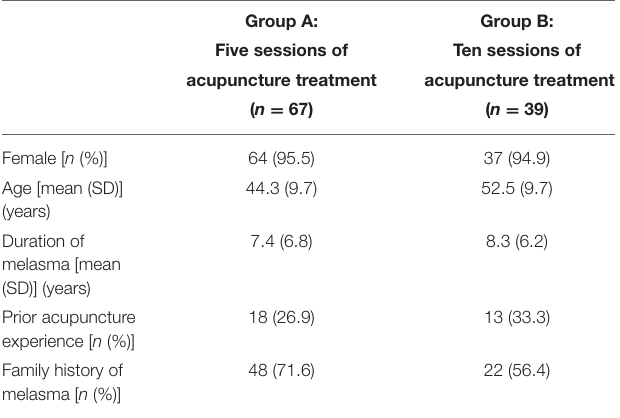
TABLE 1 | Characteristics of the